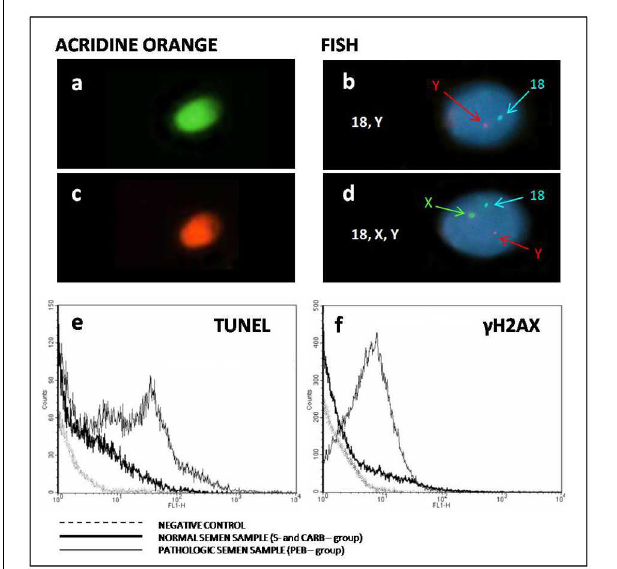
FIGURE 1 | Example of different tests performed to evaluate sperm nuclear status in surveillance and chemotherapy (CT) treated patients (Carb and PEB). (a,c) Examples of normal and altered sperm compaction. (b,d) Examples of euploid (18, Y) and aneuploid sperm (18, X, and Y). (e) Examples of single/double strand breaks observed in different groups. (f) Examples of double strand breaks observed in different